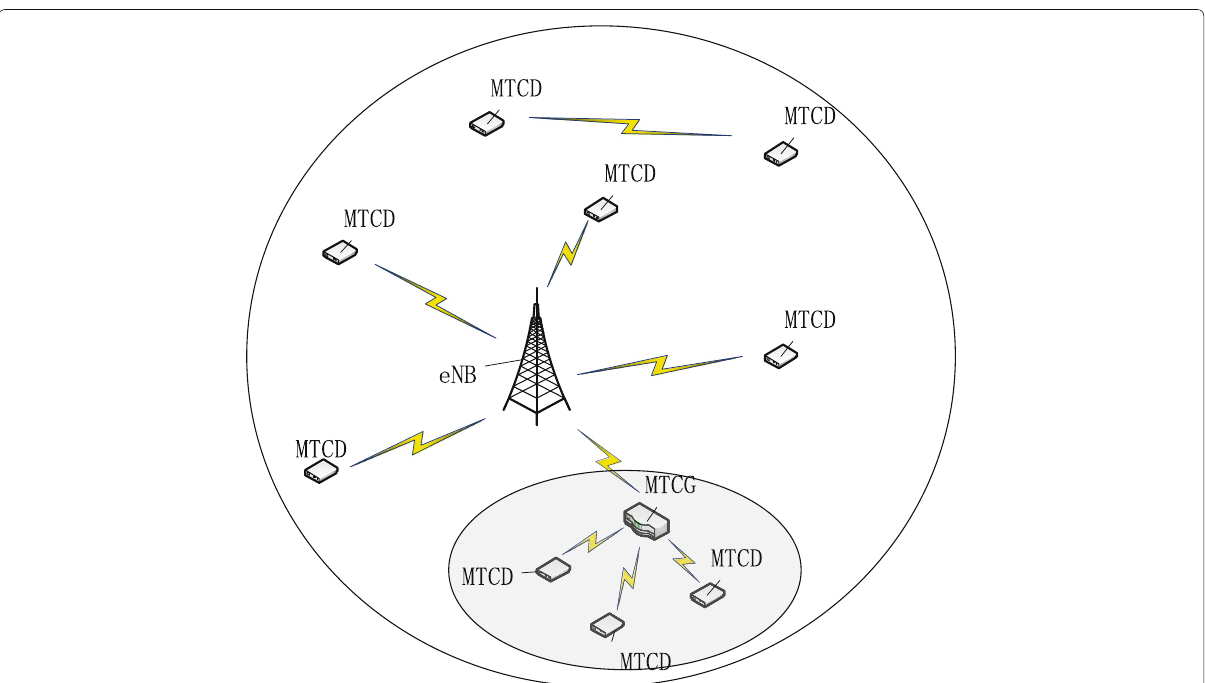
Fig. 1 The resource allocation model. It is assumed that the distance between the MTCDs and the BS is large enough to ensure that no M2M device communicates directly with the BS, and all the devices transmit data via the MTCG in the LTE-A